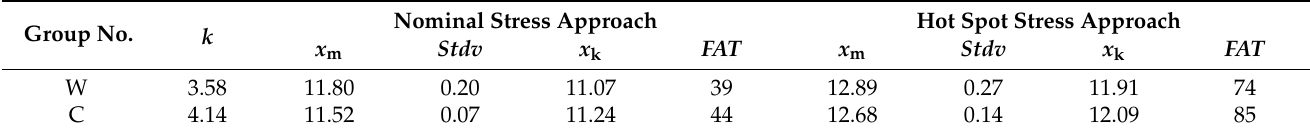
Table 5. Statistical estimation of fatigue strength.